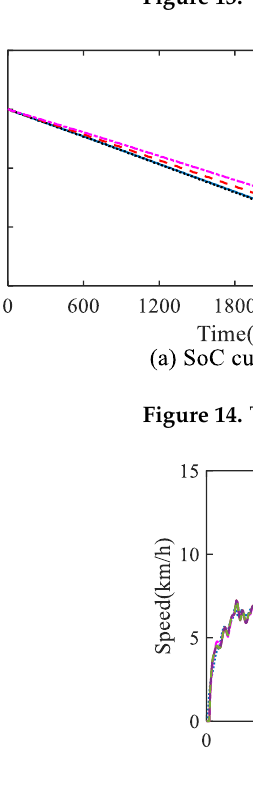
Figure 15. The vehicle speed following effect of four EMSs. Table 2. The fuel consumption of four